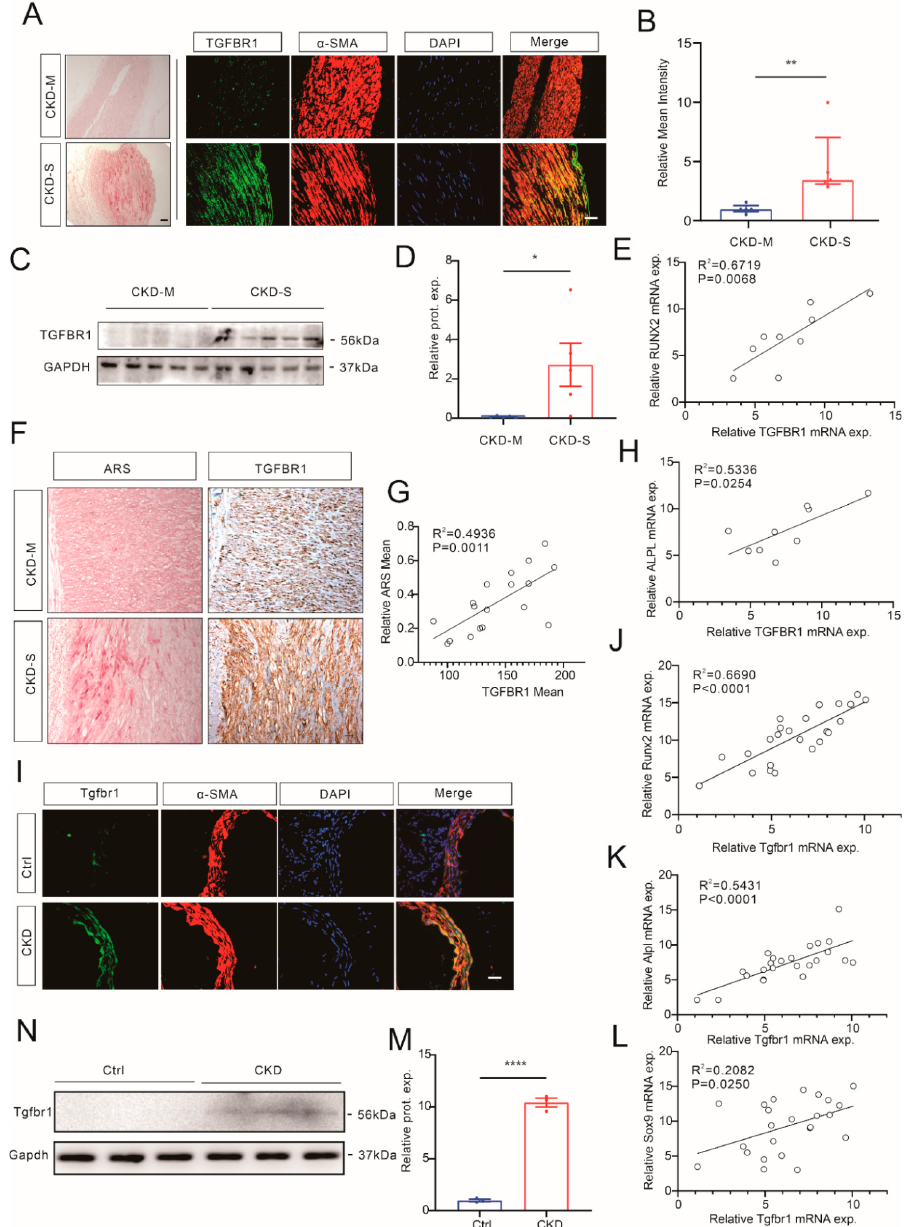
Figure 5. TGFBR1 expression level increased in calcified media of CKD. Representative IF staining ( A ) and semi-quantification ( B ) of TGFBR/ α -SMA in arteries from CKD-M and CKD-S groups (bar 40 µ M, Mann–Whitney test, n = 5). Representative images ( C ) and semi-quantification ( D ) of Western blot showing TGFBR1 levels in arteries of CKD patients (unpaired t -test, n = 5). Correlation of mRNA levels of TGFBR1 and RUNX2 ( E ) or ALPL ( H ) in arterial tissue of CKD patients. ( F ) Representative IHC staining of TGFBR1 and ARS staining of arteries from CKD patients. ( G ) Semi-quantification showing the correlation of intensity mean of TGFBR1 IHC staining and mean area of positive ARS staining in arteries from CKD patients. ( I ) Representative IF staining of Tgfbr1 (green) and α -SMA (red) of aortas from CKD mouse model and control (n = 19). Correlation of mRNA levels of Tgfbr1 and Runx2 ( J ) or Alpl ( K ), as well as Sox9 ( L ) in aortas from CKD mouse model. ( N ) Representative images ( N ) and semi-quantification ( M ) of Western blot showing Tgfbr1 levels in aortas from CKD mouse model (unpaired t -test, n = 3). * p < 0.05, ** p < 0.01, **** p < 0.0001, n.s. not significant. Scale bar, 40 µ